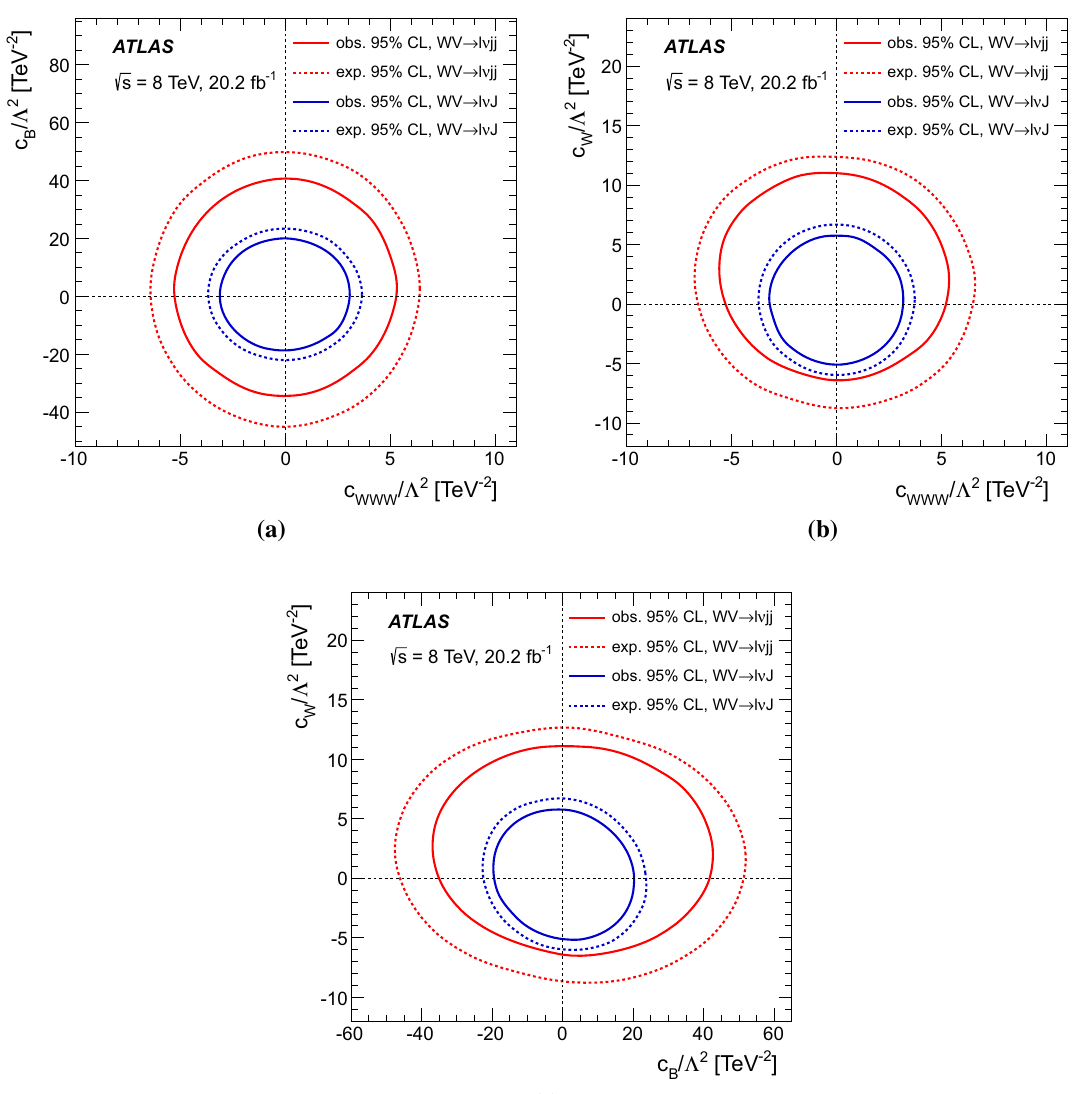
Fig. 8 The95%confidence-levelregionsforcombinationsoftwoEFT parameters. a c WWW /(cid:17) 2 and c B /(cid:17) 2 , b c WWW /(cid:17) 2 and c W /(cid:17) 2 , c c B /(cid:17) 2 and c W /(cid:17) 2 . The expected and observed confidence regions are